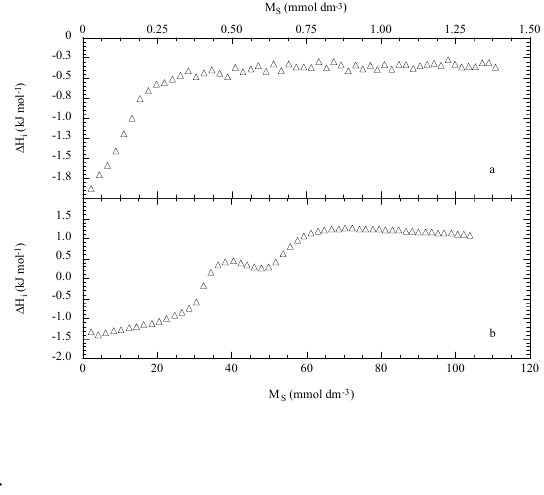
S at 293 K. Data are from Ref. 63 15